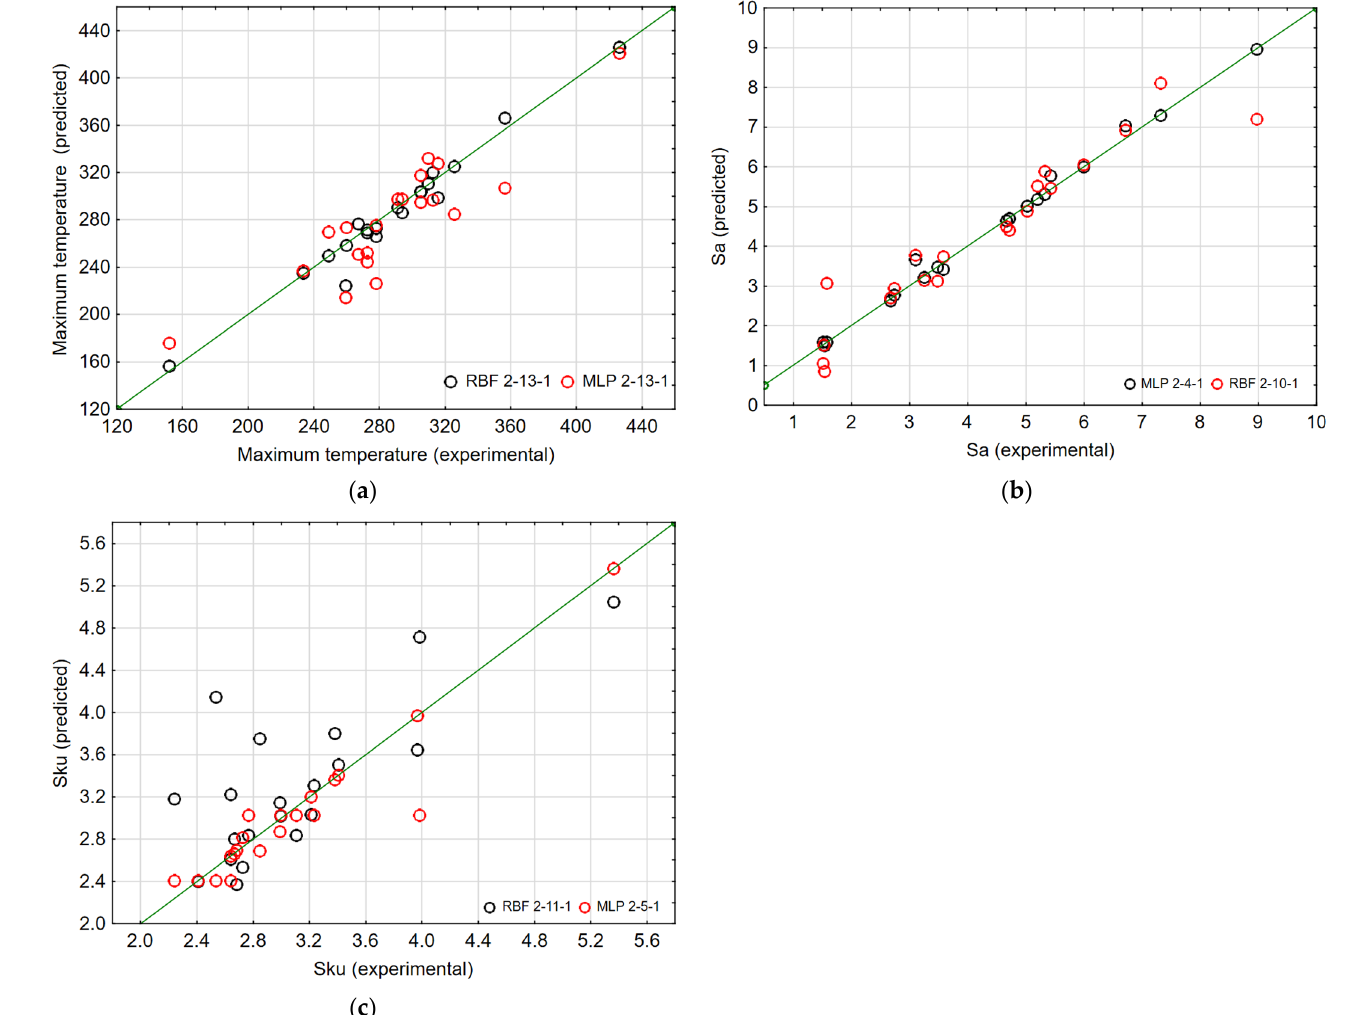
Figure 13. Correlation graph of comparison between the modelling and experimental results of the